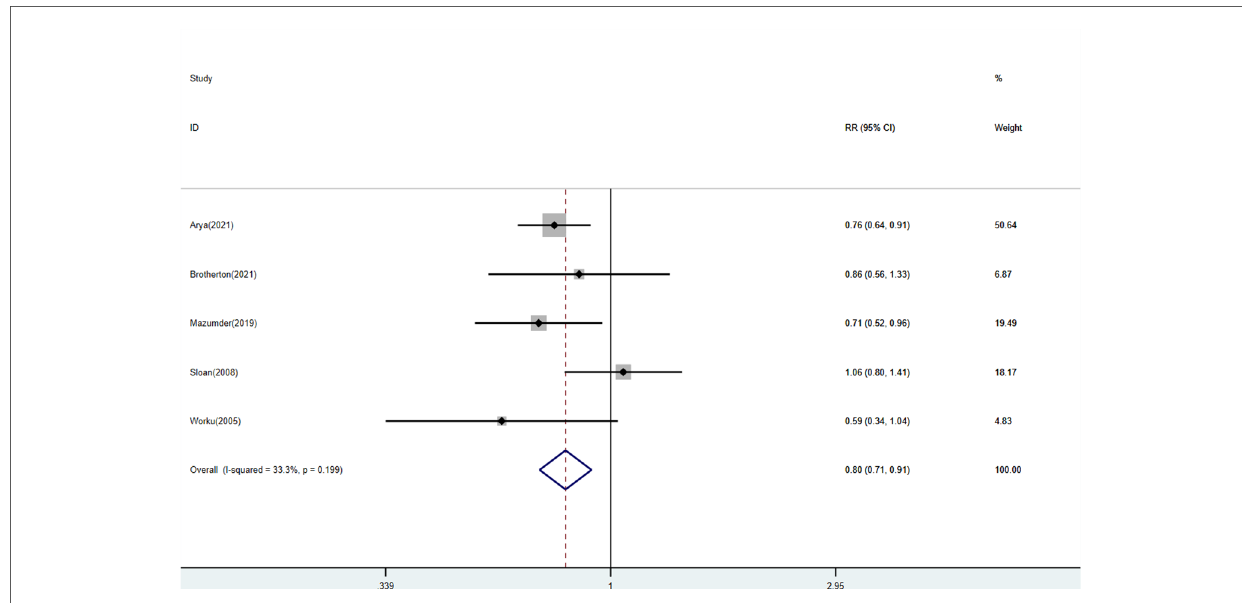
FIGURE 2 Forest plots of the mortality between enrollment and 28 days for KMC versus control